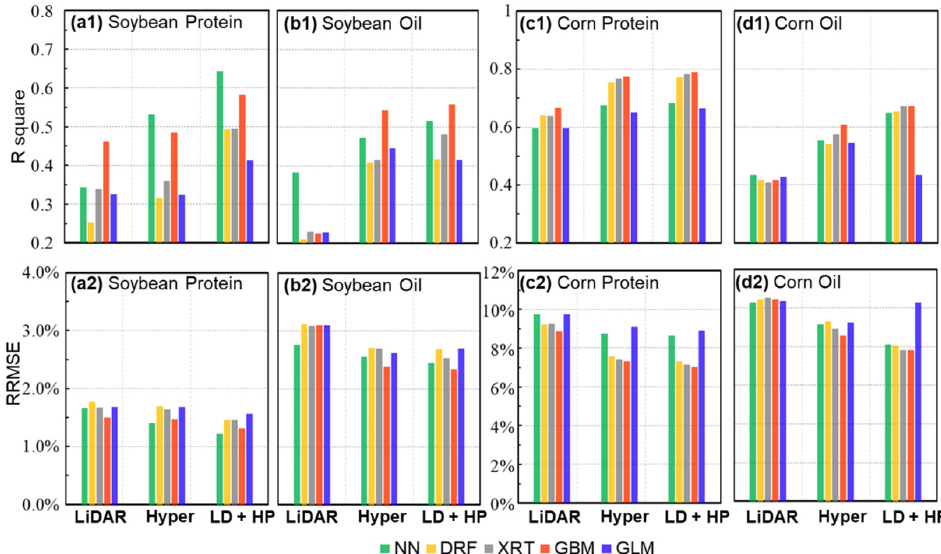
Figure 15. R 2 and RRMSE metrics when predicting soybean ( a1 , a2 , b1 , b2 ) and corn’s ( c1 , c2 , d1 , d2 ) protein and oil composition based on Hyperspectral, LiDAR and LiDAR + Hyper (LD + HP) data using different machine-learning methods (R 2 : Coefficients of Determination, RRMSE: Relative Root Mean Square Error; NN: Deep Neural Network, DRF: Distributed Random Forest, XRT: Extremely Randomized Trees, GBM: Gradient Boosting Machine and GLM: Generalized Linear Model).